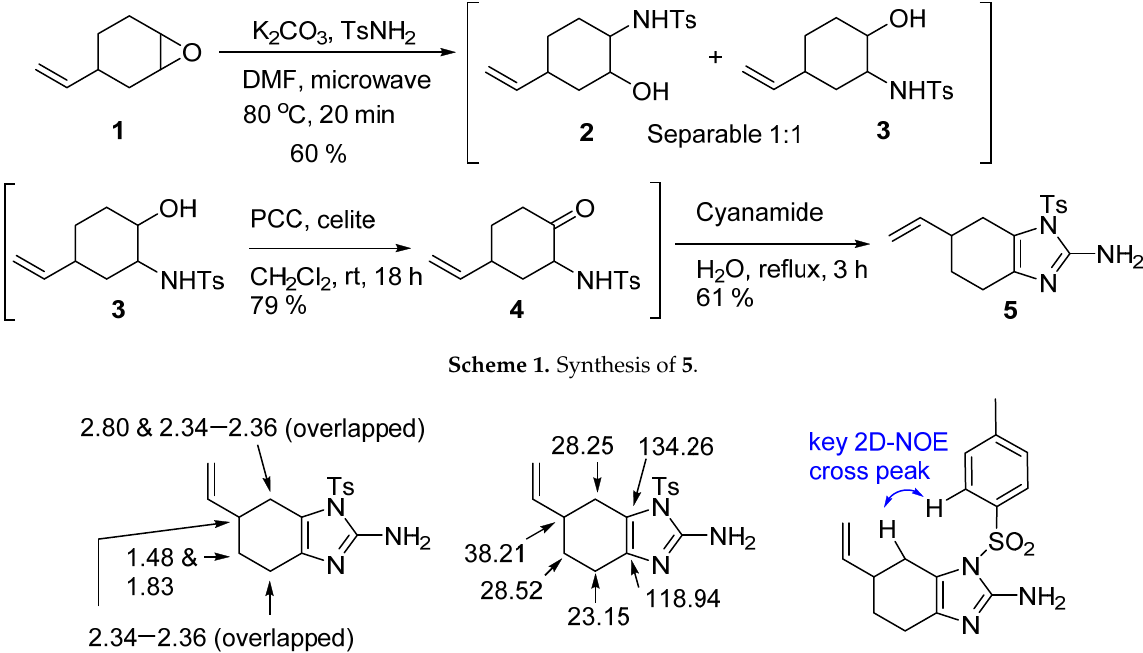
Figure 2. Selected 1 H-NMR (left) and 13 C-NMR assignments (middle) and observed NOE (right). All values given are chemical shifts ( δ ) in ppm.